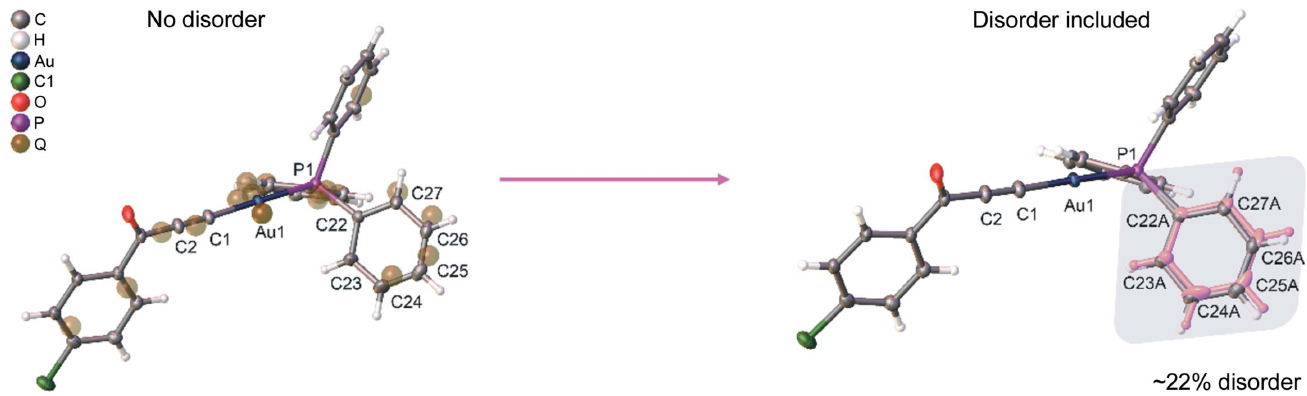
Figure 2 Structure of the [3-(4-chlorophenyl)-3-oxoprop-1-yn-1-yl](triphenylphosphine)gold(I) complex measured at 80 K. The phenyl ring shown above is affected by 22% disorder after IAM. The electron density peaks visible in the plane of the ring defined for the C22–C27 atoms (brownish transparent balls) show the second set of atomic